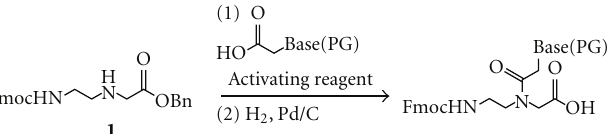
Figure 2: Synthesis of Fmoc-protected PNA monomers.